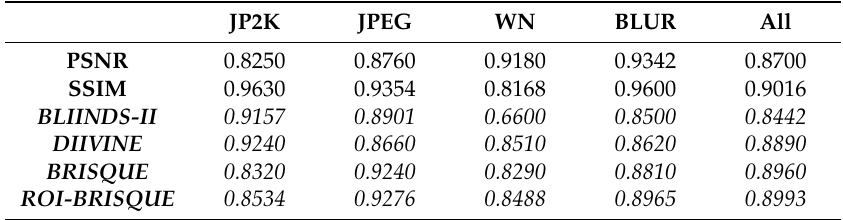
Table 7. SROCC results obtained by training on the LIVE IQA database and testing on the TID2013 database. Italicized algorithms are NR IQA algorithms, others are FR IQA